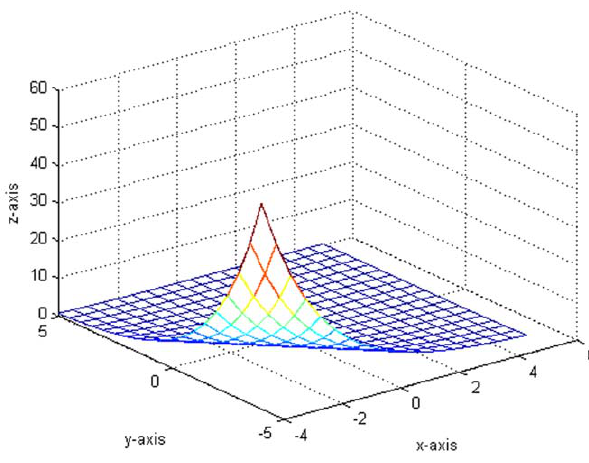
Figure 3. The plot of drawing fitted figure and original figure